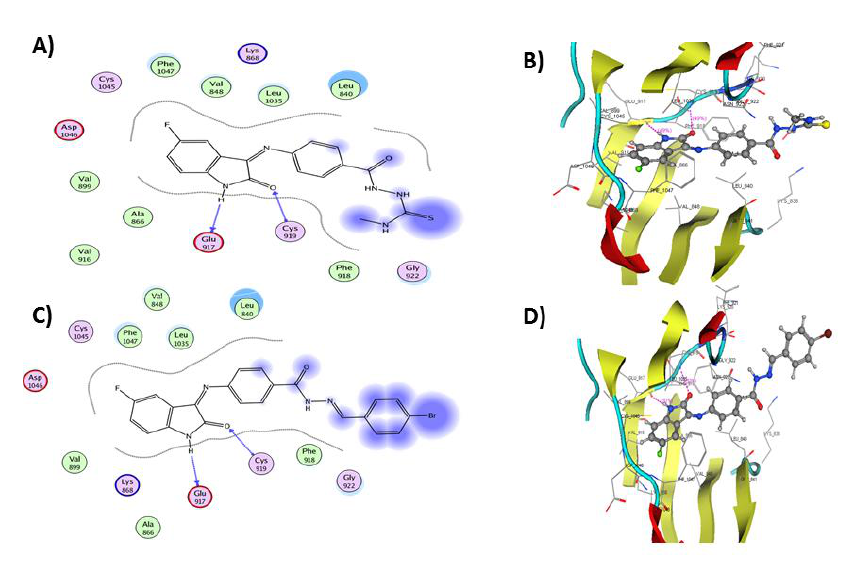
Figure 9. ( A ) 2D representation of the ligand interactions and ( B ) 3D representation of the docking of 5b in the active site of VEGFR-2 (PDB ID: 4AGD), ( C ) 2D representation of the ligand interactions and ( D ) 3D representation of the docking of 10g in the active site of VEGFR-2 (PDB ID: 4AGD). Ligands 5b and 10g are depicted in ball and stick. Amino acid residues are represented in line. Atom coloration (gray, carbon; blue, nitrogen; red, oxygen; yellow, sulfur; white, hydrogen; brown, bromine; green, fluorine).